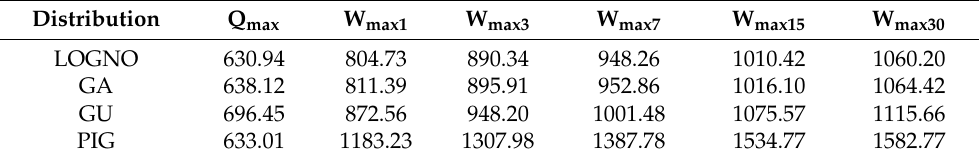
Table 3. The Akaike information criterion (AIC) was used to determine the fit of Generalized Additive Models for Location, Scale, and Shape (GAMLSS) under different probability distributions of snowmelt flood time series. Lower AIC represent a better